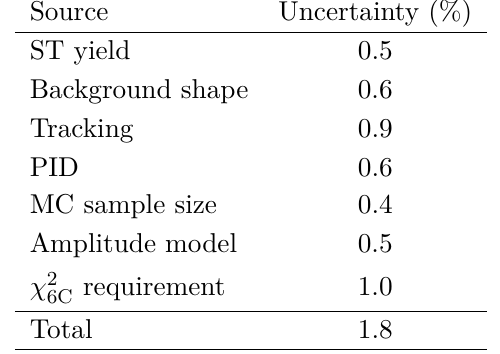
Table 10 . Systematic uncertainties in the BF